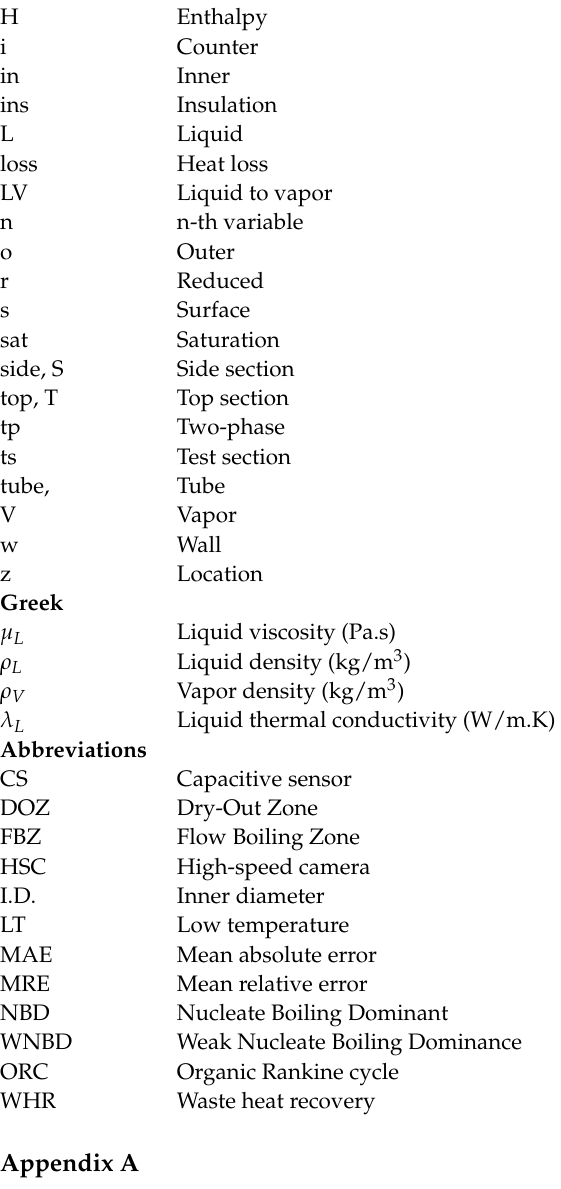
Table A1. List of experimental flow boiling studies performed between 1990–2021 with